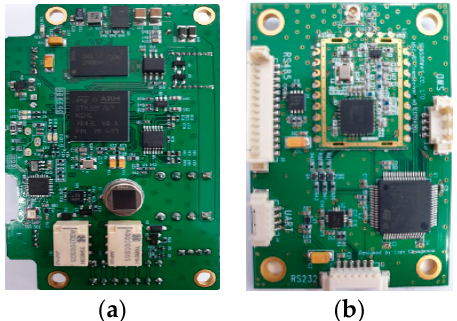
Figure 3. Applied deep learning structure (i.e., convolutional neural network). Blue cubes and solid lines present the learnable parameters. ( a ) STM32F769 board. ( b ) STM32L486 board.